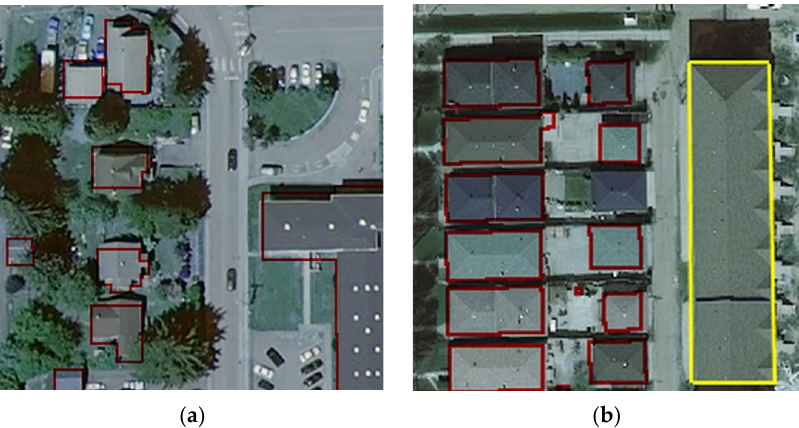
Figure 10. Aerial images with marked building footprints from cadaster (red) ( a ) Building footprints have significant offset; ( b ) New building missing the footprint (yellow).